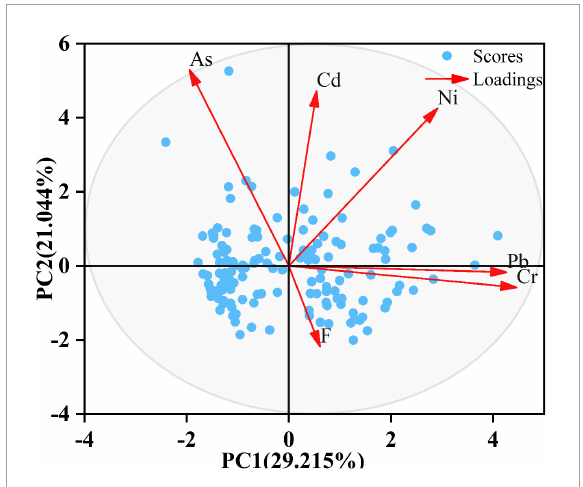
FIGURE3 The PCA biplot showing the relationships of PTE concentrations in wheat grains.